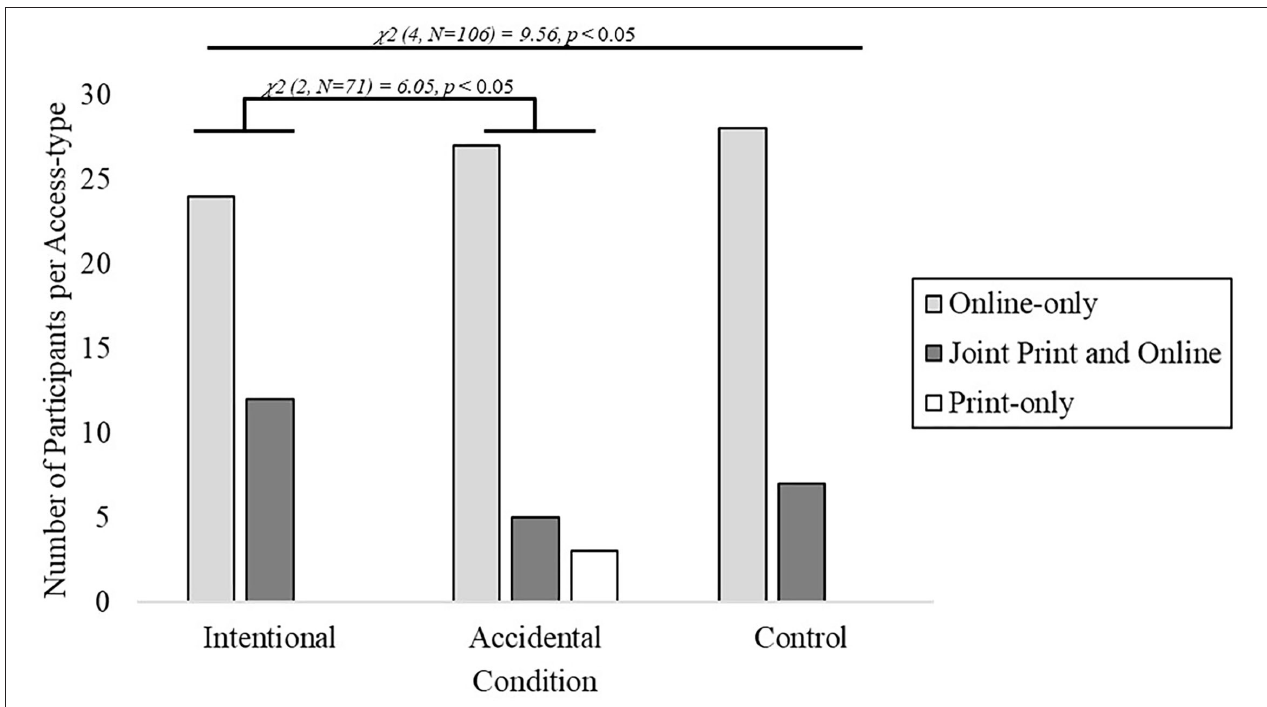
( Figure 1 ) but with two key differences. Firstly, we raised